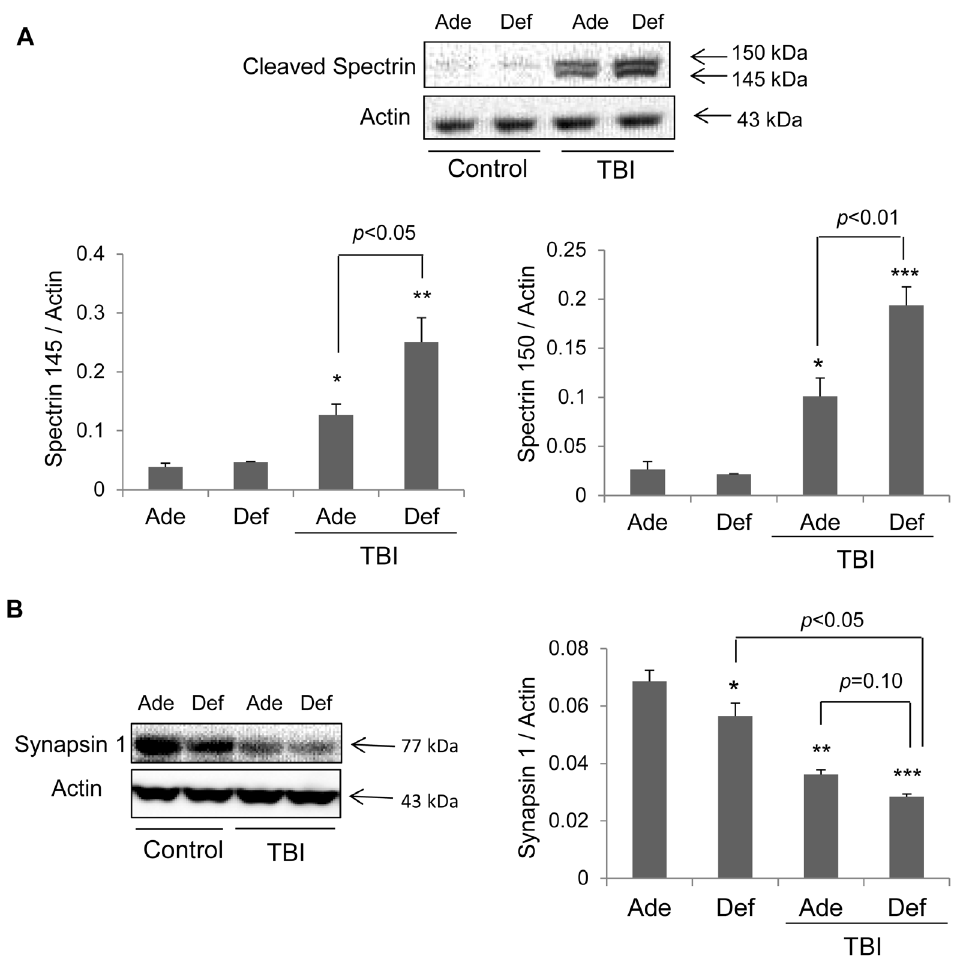
Figure 3. DHA deficiency increases TBI-induced spectrin- a II breakdown products (SBDPs) and decreases synapsin 1. (A) SBDP levels differentially increased after TBI in the affected cortices of DHA adequate (Ade) and deficient mice (Def). The contralateral cortices were used as controls. The deficient TBI group showed a significantly greater increase in SBDP levels after TBI for both 145 kDa and 150 kDa fragments as compared to the adequate TBI group ( n= 4 ) . (B) Synapsin 1 level affected by TBI and DHA depletion. TBI significantly decreased the synapsin-1 level in both diet groups. DHA depletion lowered the synapsin significantly ( p , 0.05) in the non-injured mouse cortices. Although statistical significance was not reached, a trend of further decrease in synapsin 1 level after TBI was observed with DHA deficiency. * p , 0.05; ** p , 0.01; *** p , 0.001 compared to the non-injured adequate group.